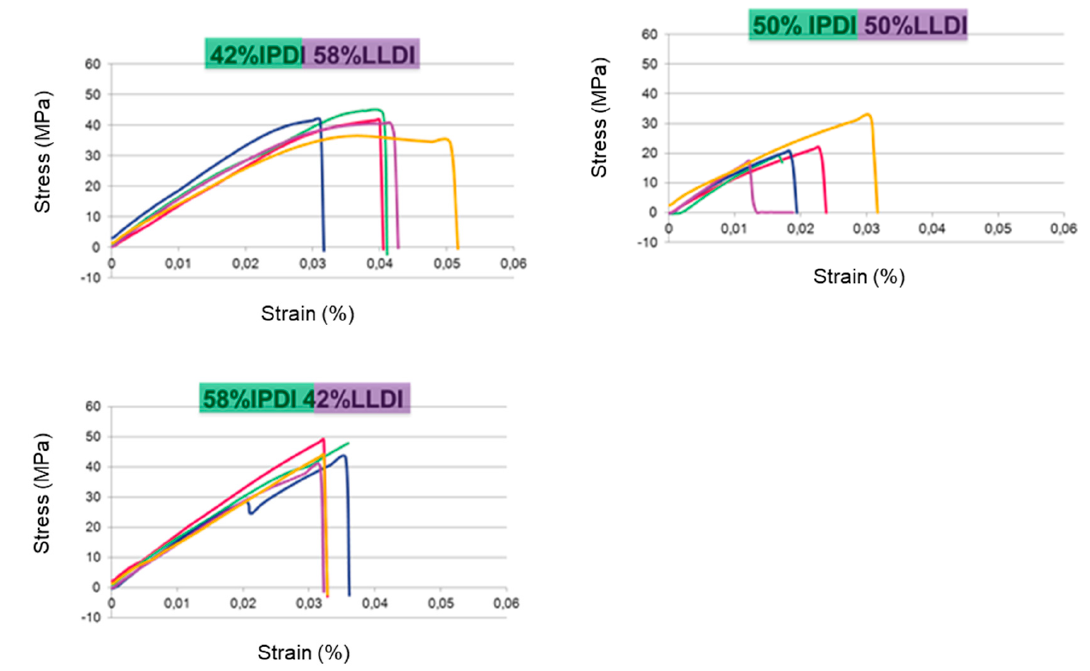
Figure 3. Stress–strain behavior of PUs with different IPDI/ ethyl ester L-lysine diisocyanate (LLDI) ratios.